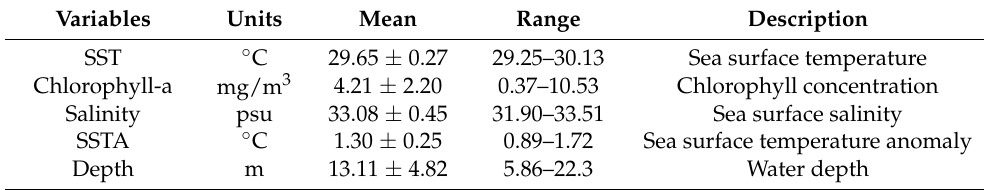
Table 1. The Description of environmental factors.